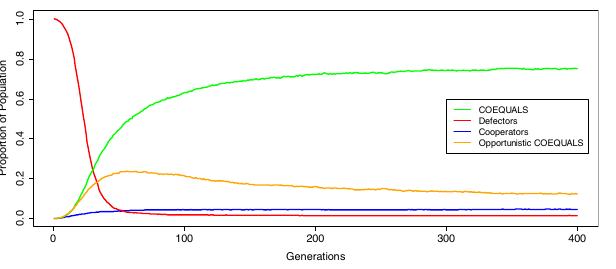
Figure 5. Robustness of COEQUALS to a variant that seeks to defect in the final game of a generation. The figure indicates the limited success of Opportunistic COEQUALS—a strategy that mimics COEQUALS, yet attempts to identify the final one-shot game in a generation and defect in it. Theoretically, COEQUALS appears vulnerable to this variant because it would gain the benefits of free-riding and impose the costs of cooperation on COEQUALS just prior to reproduction, thus acquiring a definitive fitness advantage. However, when the final game of a generation remains unknown, Opportunistic COEQUALS might defect prior to the final round of a generation, thus creating wealth inequality that gives COEQUALS agents the opportunity to avoid adopters of the variant and return to higher levels of fitness via mutually cooperating with other COEQUALS agents. The results in Fig. 4 dovetail with that possibility. The results show the median of the distribution of each strategy’s population share across every generation of the simulation. COEQUALS and the opportunistic variant hold the same median value until the 15 th generation of the simulation at which point the median of the distribution containing COEQUALS’ population shares increases relative to that of Opportunistic COEQUALS. Opportunistic COEQUALS, however, remains a non-trivial proportion of the population; the median of its distribution of population shares reaches a maximum value of 0.236 in the 57 th generation of the simulation and it remains at 0.123 at the end of the simulation. Despite this presence, the variant is eclipsed by the success of COEQUALS. The median value of COEQUALS’ distribution of population shares reaches its maximum value in the 346 th generation and hovers about this value through the end of the simulation, reaching it again in the 398 th generation. Indeed, from the 200 th generation onward, it continues to increase the median value of the distribution of its population shares, growing from approximately 0.72 at g = 200 to a final value of 0.75 at g = 400. Cooperators and defectors, on the contrary, constitute a trivial portion of the population throughout the simulation runs, with the latter strategy falling precipitously from its initial incumbent